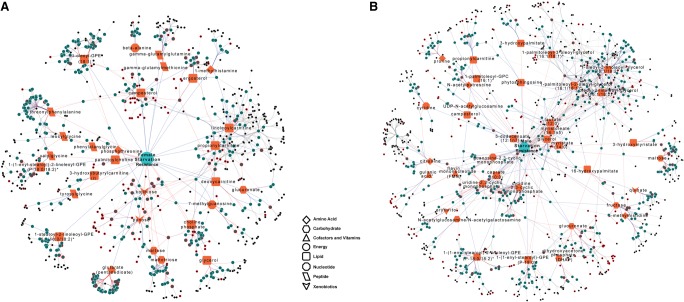
Integrated networks that incorporate polymorphic markers, variation in candidate gene expression, and variation in metabolite abundances associated with variation in starvation resistance for females (A) and males (B). Orange nodes indicate metabolites correlated with starvation resistance and teal nodes indicate candidate genes correlated with these metabolites. Black nodes indicate mQTL associated with candidate genes. Nodes with red borders indicate a direct association with the organismal phenotype. The different shapes of the orange nodes indicate different metabolic super pathways. Red edges indicate positive correlations, while blue edges represent negative correlations. Black edges connect polymorphic markers with their associated genes. The polymorphic markers, candidate genes, and metabolites presented in the figure are listed in Supplemental Table S12.